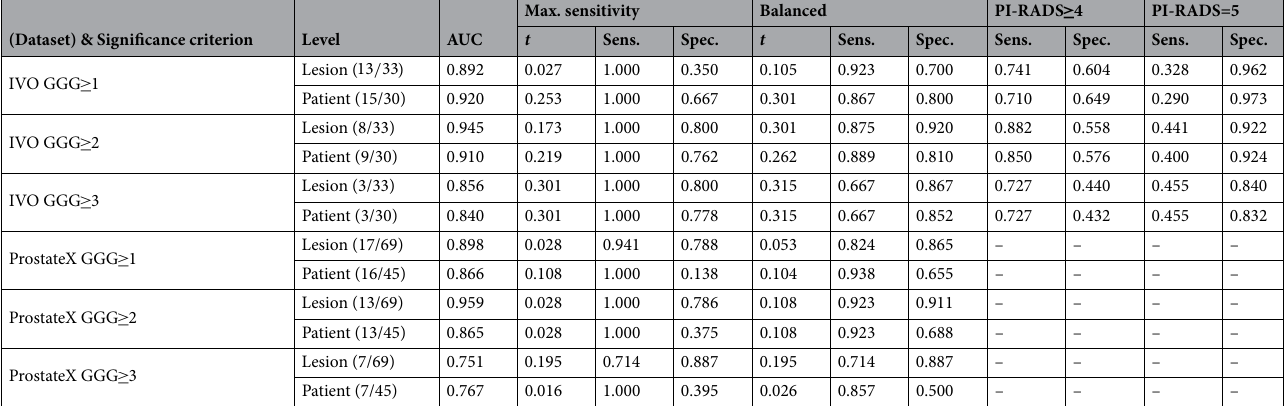
Table 1. Quantitative results for IVO (top) and ProstateX (bottom) test data evaluated with different Gleason Grade Group (GGG) significance criteria (e.g. lesions with GGG ≥ 1, 2, or 3 are considered positive), at lesion- and patient-level ( N positives / N total ), and at two thresholds ( t ): maximum sensitivity and balanced. For IVO data, results are compared with radiologist-assigned pre-biopsy PI-RADS scores for all IVO patients with no missing sequences and with PI-RADS information available (N=106 patients, 111 lesions). AUC: Area under the ROC curve.